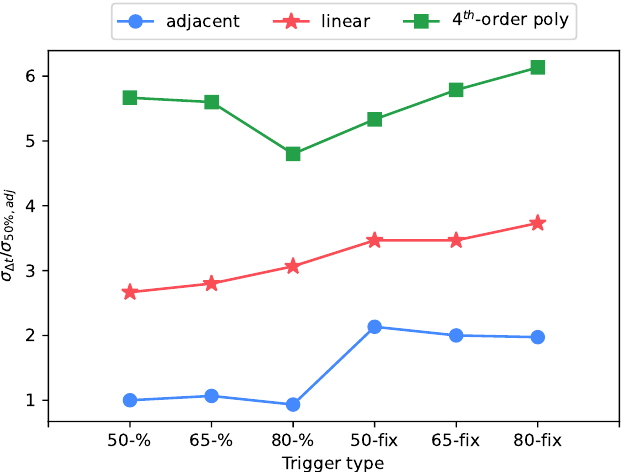
Figure 8. Standard deviation of arrival time shift: test case at 8.1 µ s rise time, 1 V of full scale